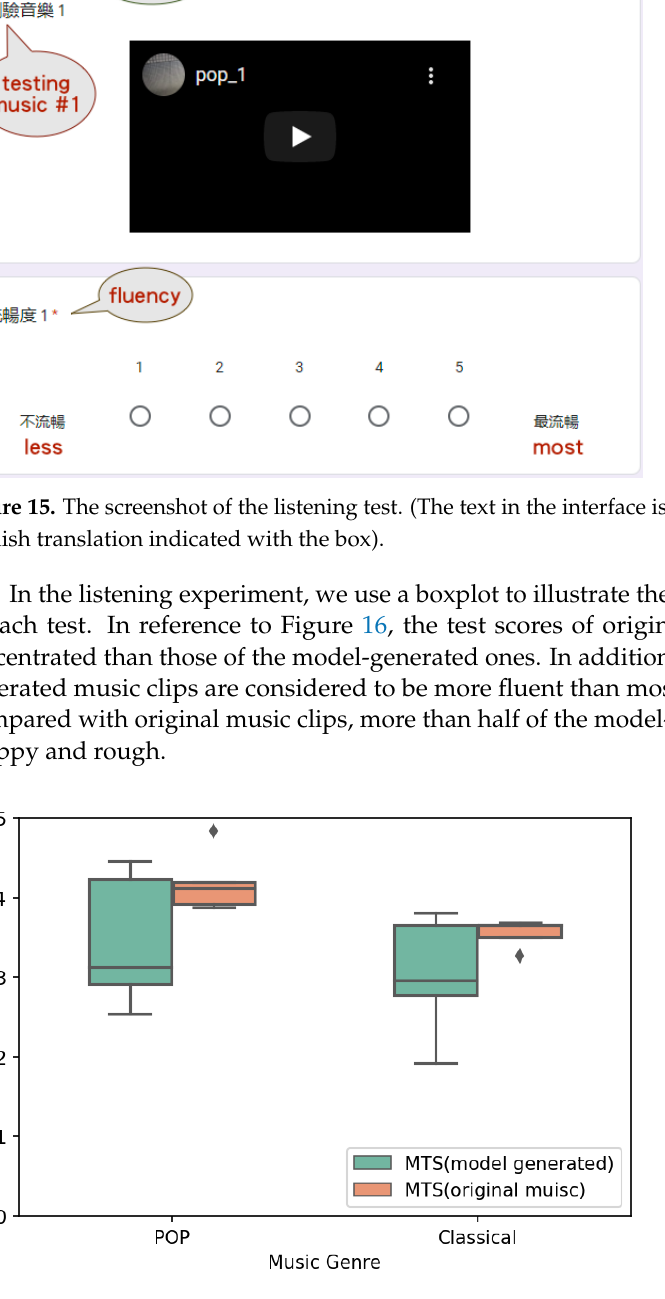
Figure 16. The boxplot of test